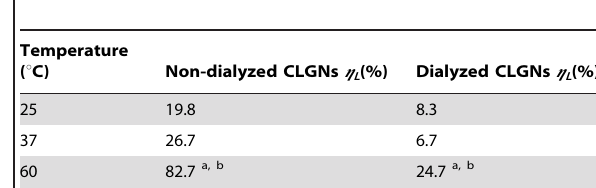
Table 3. Glucoamylase Immobilization Efficiency by Adsorption Method Using Dialyzed and Non-dialyzed CLGNs at Different